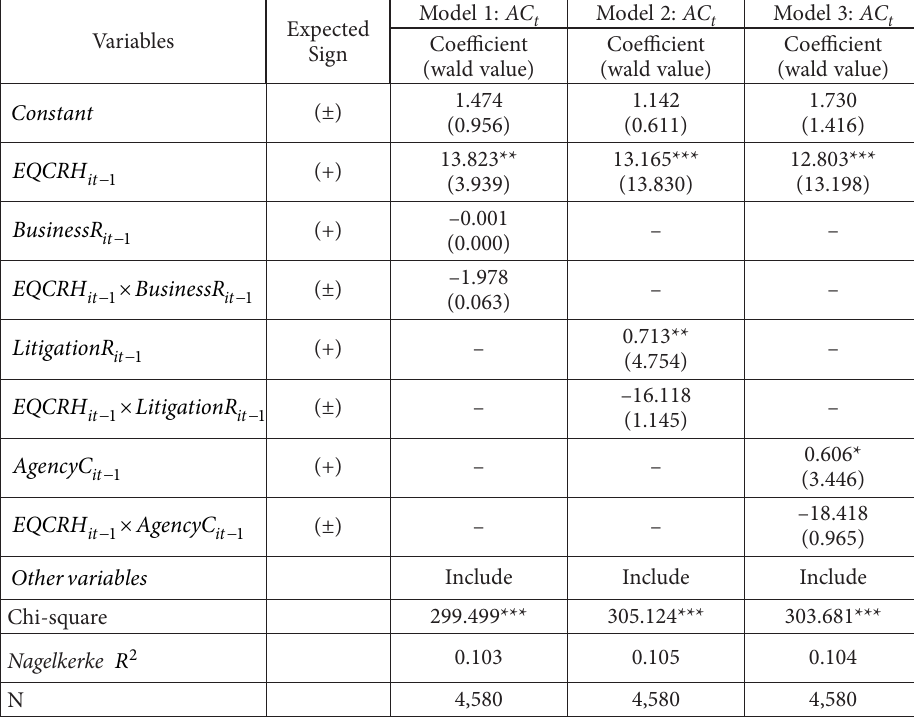
Table 6. Results for the effect of business risk, litigation risk, and agency costs on auditor changes